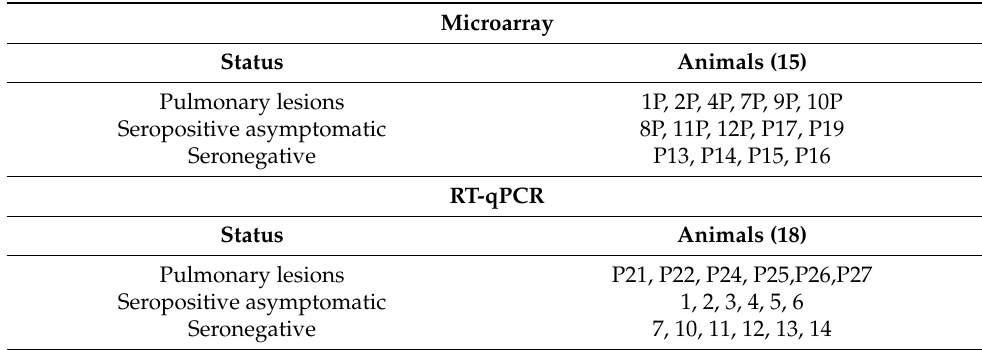
Table 1. Samples used in Microarray and RT-qPCR